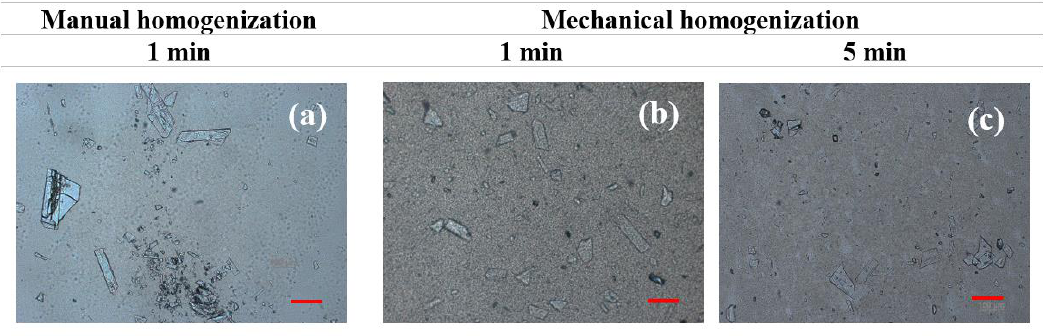
Figure 4. - Micrographs of oil-in-gel emulsion A after KHE incorporation for 1 min manually ( a ) and mechanically for 1 min ( b ), and for 5 min ( c ) at 25 °C (the scale bar corresponds to a length of 100 μm).